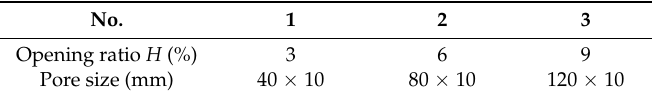
Table 3. The pore size and the opening